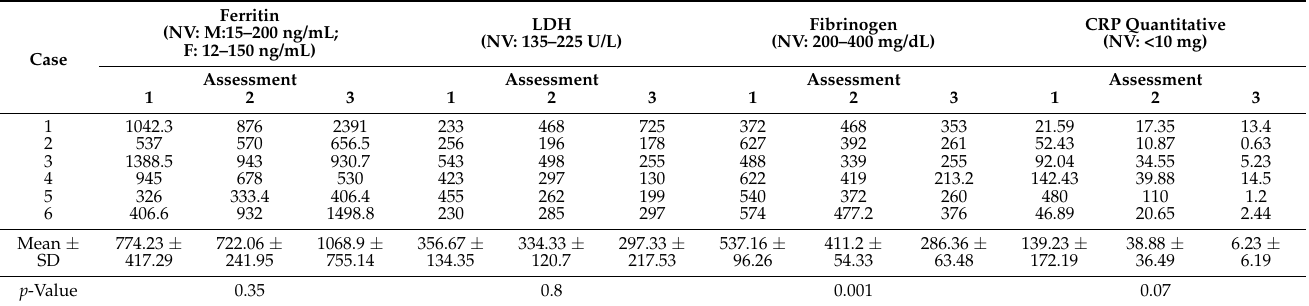
Table 2. Patients’ characteristics according to the serum levels of ferritin, LDH, fibrinogen, and CRP.